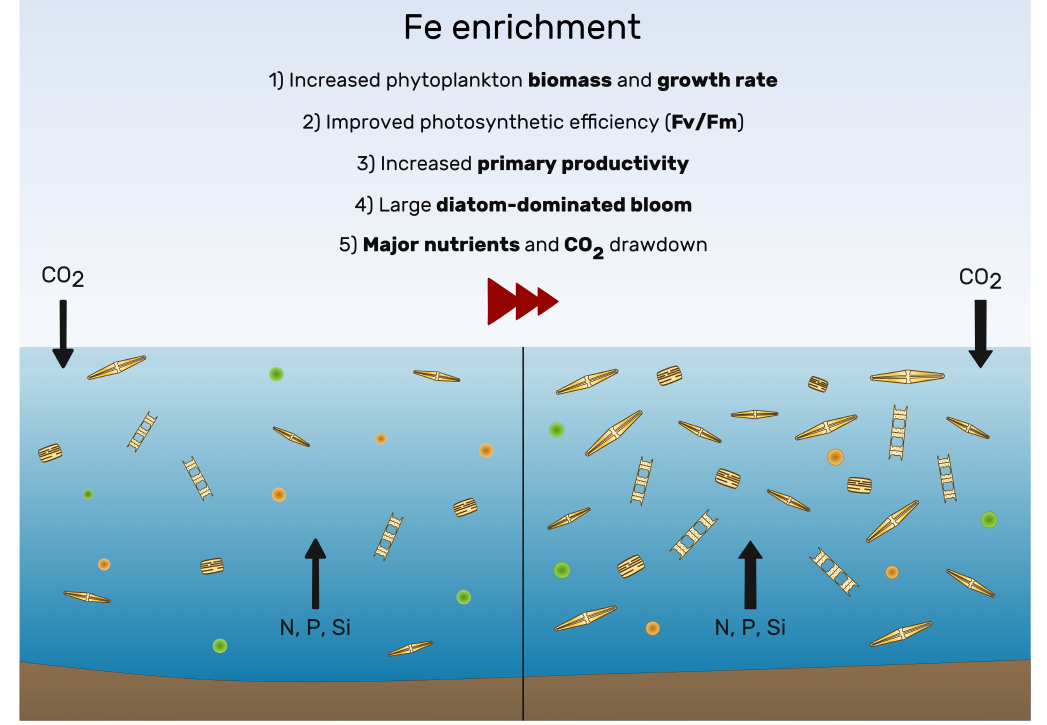
Figure 2. Main effects of artificial Fe enrichment experiments. Abbreviations: Fe stands for iron, CO 2 for carbon dioxide, N for nitrogen, P for phosphorous, Si for silicates, Fv/Fm indicates photosyn- thetic efficiency. Table 1. This table summarizes the main experiments conducted to test the Fe hypothesis and how Fe concentration impacts phytoplankton growth. Emphasis is on the variety of sampling sites and periods. Abbreviations: SOIREE stands for SO Iron Release Experiment; in EisenEx, “Eisen” means Fe in German; SOFeX-N,S for SO Fe experiment North and South; EIFEX for SO European Iron Fertilization Experiment; SAGE for Surface Ocean–Lower Atmosphere Study (SOLAS) Air–Sea Gas Exchange; in LOHAFEX, “Loha” means Fe in Hindi; CROZEX for CROZet natural iron bloom and EXport experiment; KEOPS 1,2 for Kerguelen Ocean and Plateau compared